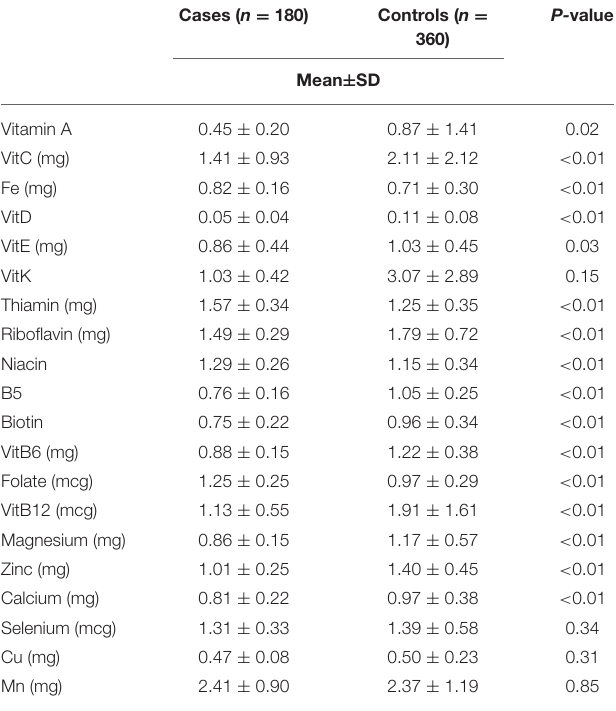
TABLE 3 | Comparison of the index of nutritional quality (INQ) of breast cancer patients and control group. Cases ( n =